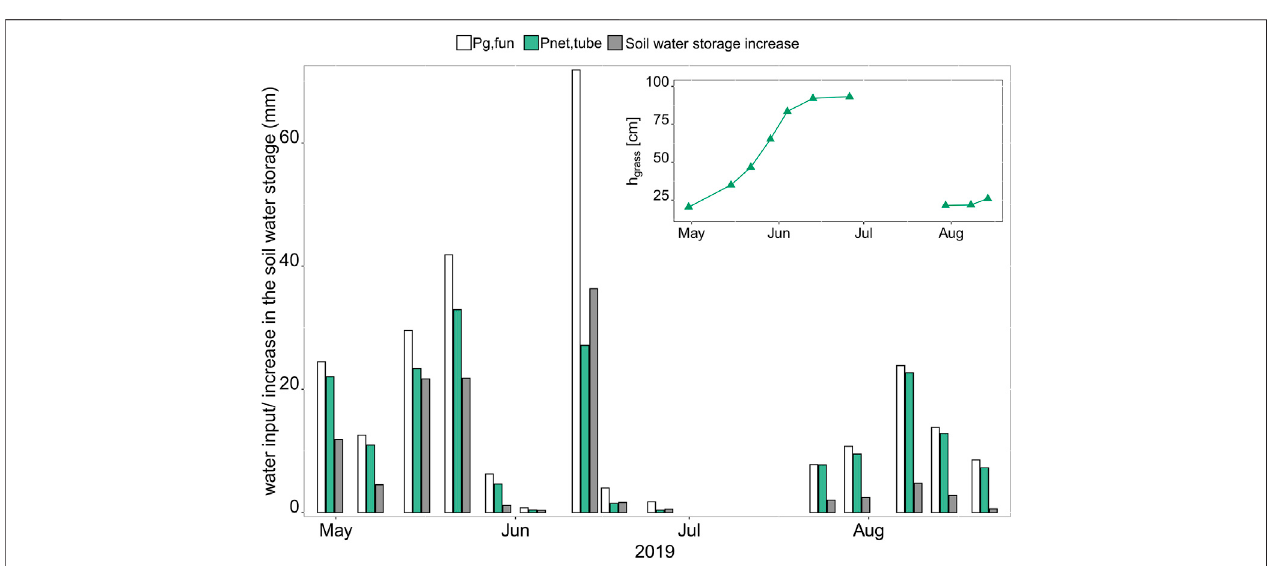
FIGURE7| Weeklyspatialmeanofgrossprecipitation(P g,fun ),netprecipitation(P net,tube )andincreaseinthesoilwaterstorageforthesoilcolumn0 – 37.5 cmdepth during the covered period. Soil water storage was calculated based on the soil moisture sensors in the topsoil (7.5 cm) and sub soil (27.5 cm). Inlet: Weekly spatial average of grass height. Only values of h grass > 15 cm are shown, the interruption in the time series is due to the annual